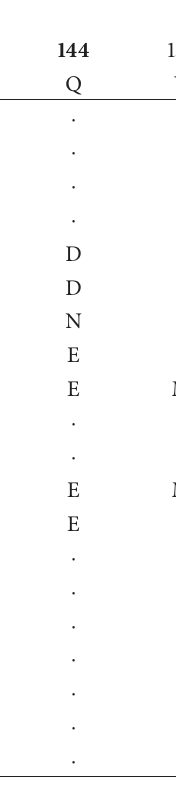
Table 3: Amino substitution in VP1 sequence of CAV